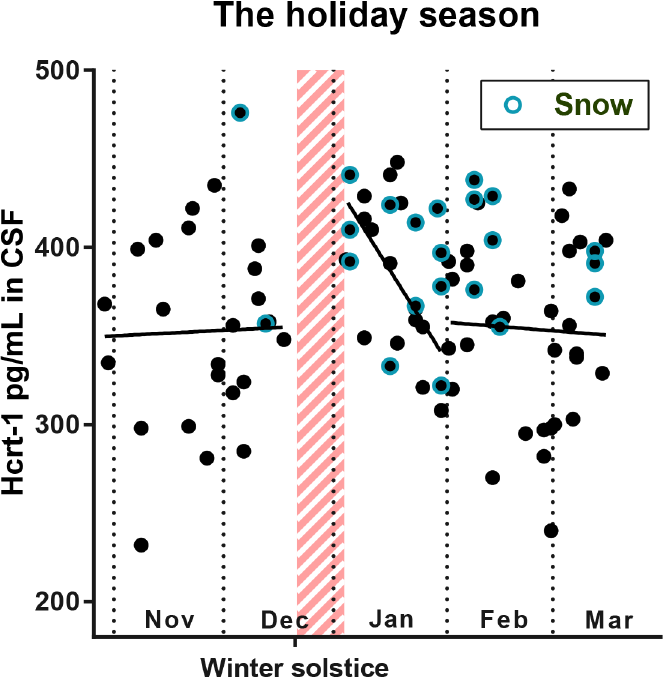
Fig 3. CSF hcrt-1 levels around Christmas vacation in Denmark. Shown are linear regression fits of data excluding days of snow and divided into three parts: Nov-Dec (non-significant), Jan (p = 0.03), and Feb- March (non-significant). The Christmas vacation is marked with red and data sampled on days with snow are marked with a blue circle.